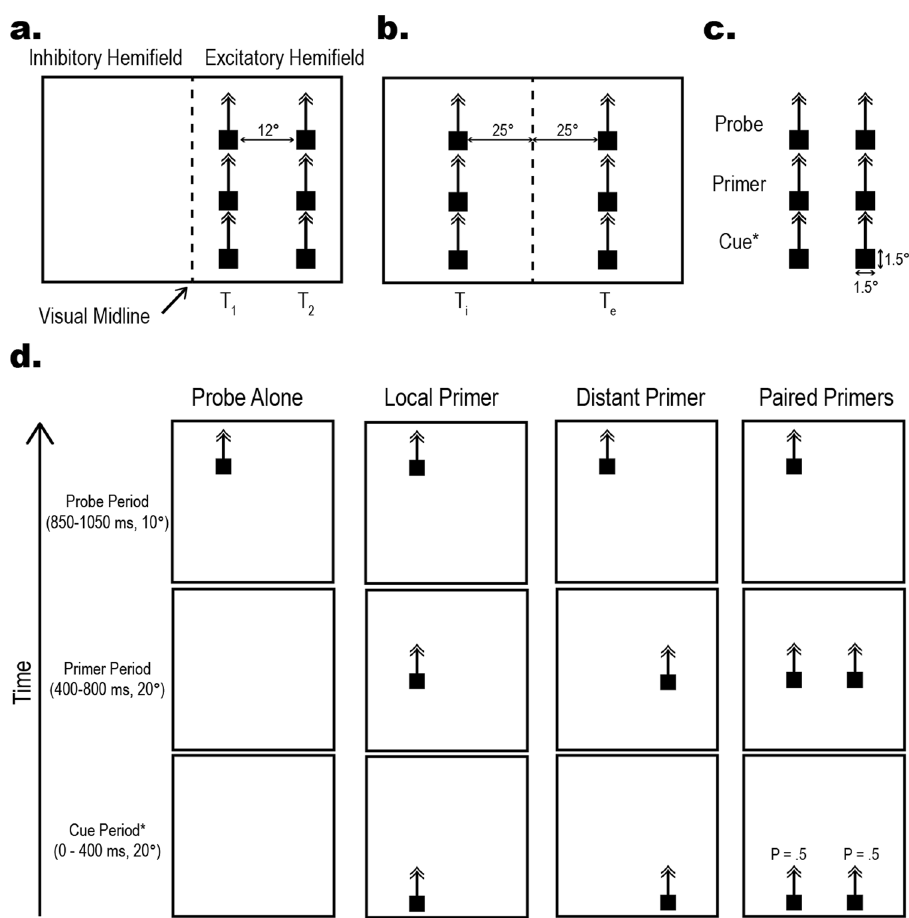
Fig. 7 Stimulus pictograms depicting stimulus trajectories and permutations. a Illustration (not to scale) of the target locations along two rival trajectories. Rival trajectories spaced 12° apart in the excitatory receptive fi eld. T 1 refers to the target on the midline-adjacent trajectory, while T 2 refers to the target on the more peripheral trajectory. b In the cross-hemispheric experiments the trajectories are 50° apart, equidistant from the visual midline (dotted line). These targets are named T i (Target-inhibitory) and T e (Target-excitatory) based on the visual hemi fi eld in which they reside. c Trajectories are divided into three vertical sections, the Cue, Primer, and Probe section. d Target position over time (ascending Y) in a subset of conditions representative of the base experiment. These four trials illustrate the T 1 trials and are intermixed with mirrored T 2 trials (not shown for brevity). The cross hemispheric experiments use the same basic pattern; however, trajectories are further apart and centred on the midline as described above ( b ). * The Cue Period stimuli are only presented in a subset of Cue-related experiments. In Cued, Paired-Primer trials there is an equal chance for the Cue to be present on either T 1 or T 2 , but never